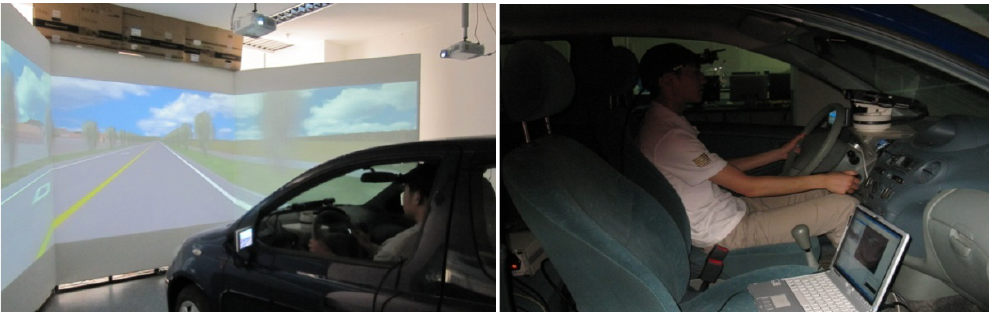
Fig.2. Driving simulator system used in this experiment